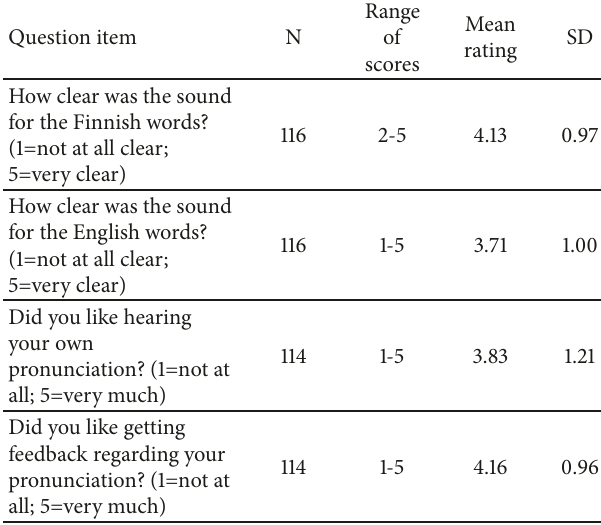
Table 5: Reactions from the SIAK application relating to speech and audio elementsusing the smiley-o-meterrating scale(NB: some items had lower N due to participants not filling in every